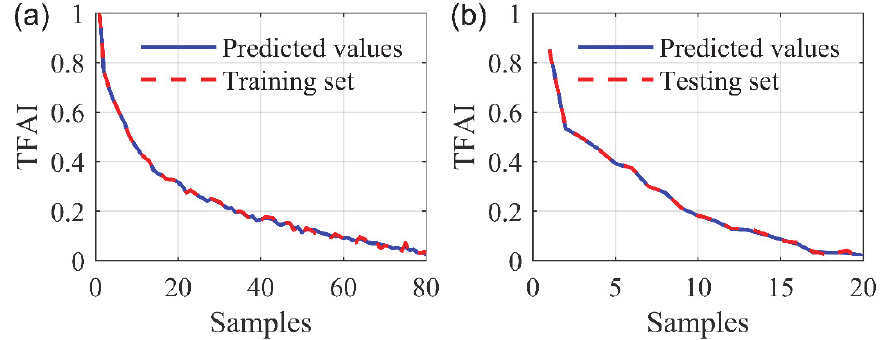
Figure 5. Training and testing results of support vector regression model: ( a ) training dataset; ( b ) testing dataset.